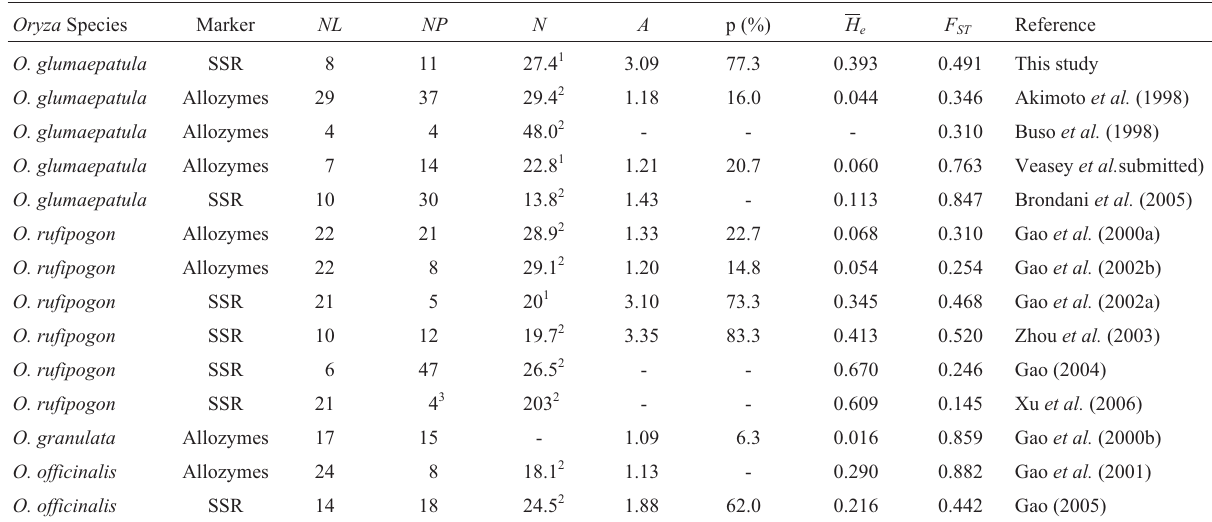
Table 7 - List of studies on genetic diversity of several Oryza species using microsatellites (SSR) and allozyme markers, including number of loci as- sessed (NL), number of populations analyzed (NP), mean sample size per locus or population ( N ), mean number of allele per locus (A), percentage of polymorphic loci (p), gene diversity ( H e ) and Wright’s among population diversity ( F ST ) parameters. Oryza